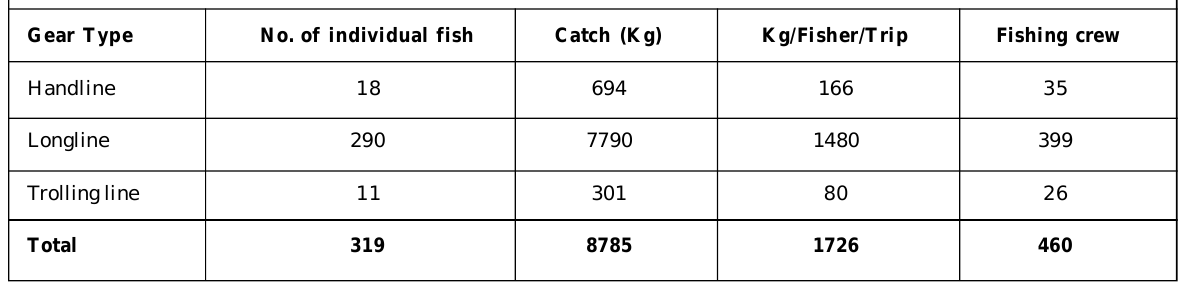
Table 2: Proportion of swordfish landed by different gears deployed by artisanal fishers in Kenya coastal waters